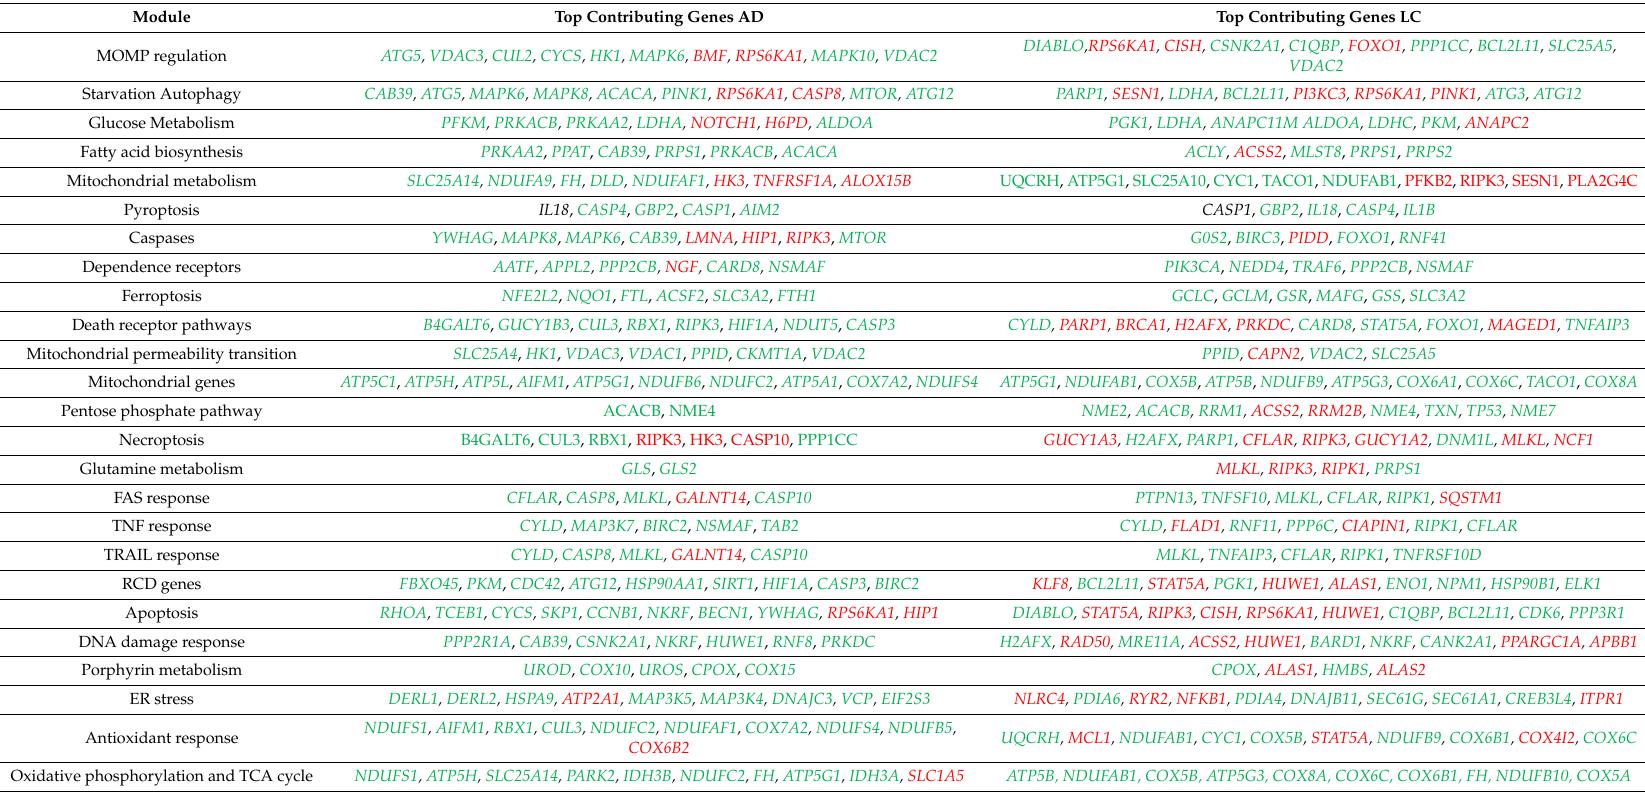
Table 2. Top contributing genes per module for Alzheimer and lung cancer